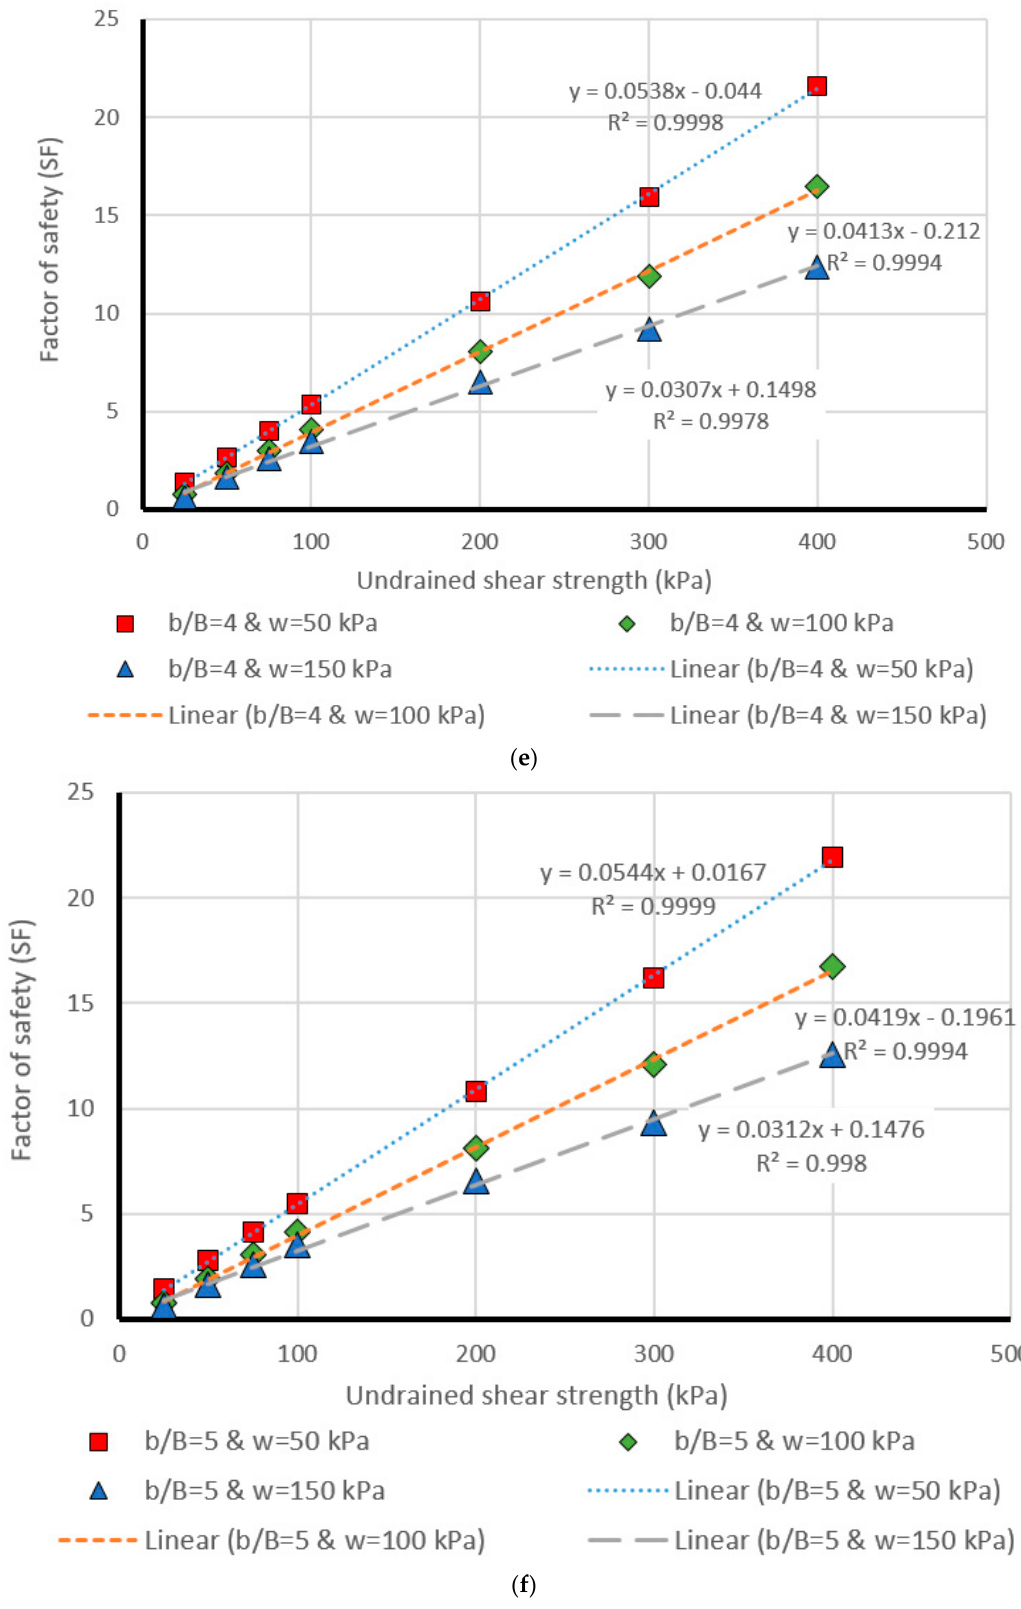
Figure 10. Comparison of the MLP estimation and real values of FS for the β = 45°, ( a ) b/B = 0, ( b ) b/B = 1, ( c ) b/B = 2, ( d ) b/B = 3, ( e ) b/B = 4, ( f ) b/B = 5.